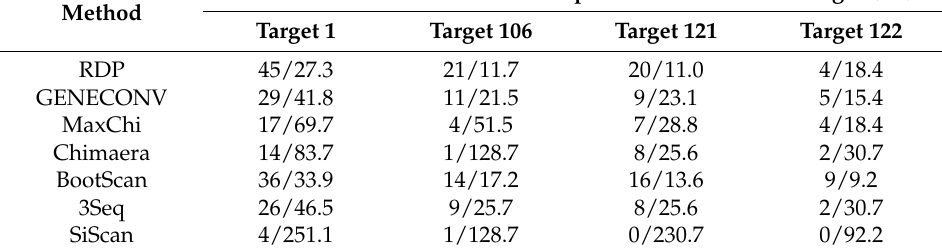
Table 2. Comparison of the number of recombination breakpoints and mean c-gene size based on seven different recombination detection methods implemented in RDP4 [62] that were applied to four target regions from Hobolth et al.